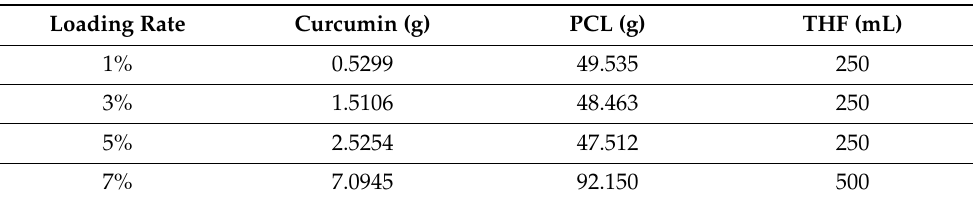
Table 1. Amount of curcumin, poly(caprolactone) (PCL), and tetrahydrofuran (THF) used for solvent casting of curcumin-loaded PCL